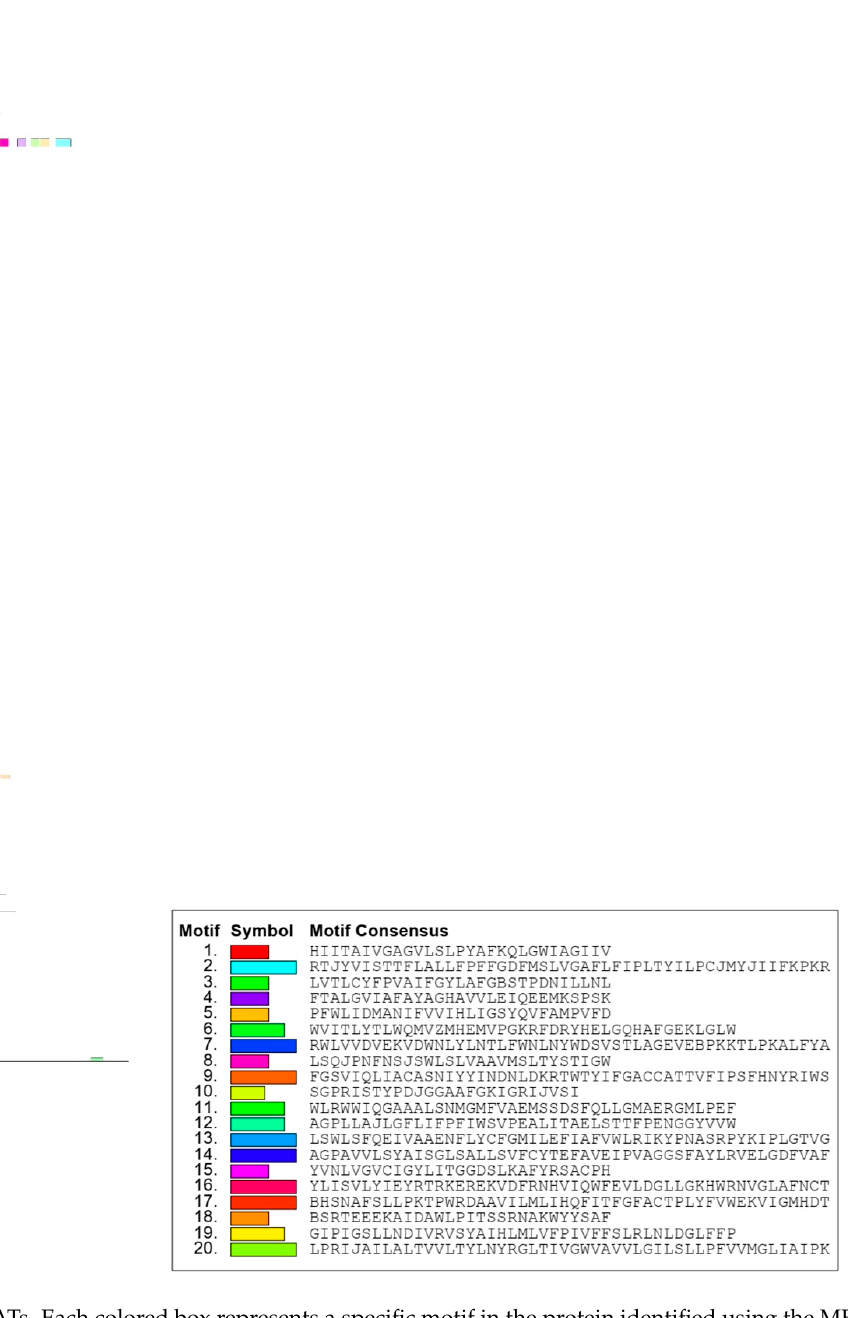
Figure 4. Protein motifs of SlAATs. Each colored box represents a specific motif in the protein identified using the MEME motif search tool (For interpretation of the references to colors in this figure, the reader is referred to the web version of this article.) AAP, amino acid permease; ANT, aromatic and neutral amino acid transporter; ATL, amino acid transporter-like proteins; BAT, bidirectional amino acid transporter; CAT, cationic amino acid transporter; GAT, γ -aminobutyric acid transporter; LAT, L-type amino acid transporter; LAX, like-auxin influx carriers; LHT, lysine/histidine transporter; ProT, proline transporter; TTP, tyrosine-specific transporter; VAAT, vesicular aminergic-associated transporter.